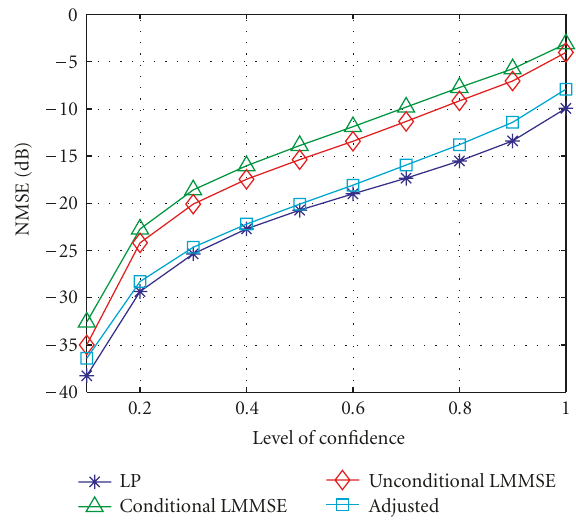
Figure 6: Probability of channel prediction error less than 20% ( L = 0 . 5 λ , N = 100, 8 rays).